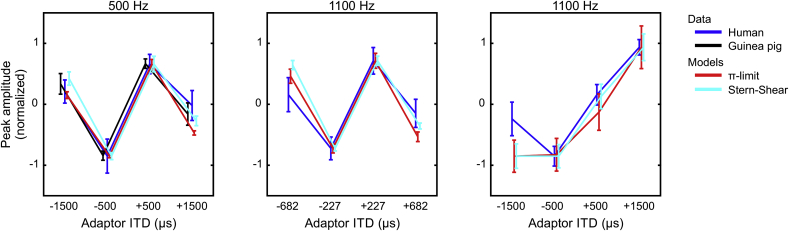
Predicted response amplitudes (average ± standard error of the mean over ten repetitions) from the computational model for the two distributions compared to the MEG data from humans and ECoG data from the guinea pig (plotted as in Fig. 3, Fig. 4). For illustration, peak amplitudes of the model predictions and ECoG data are scaled to have the same maxima and minima as the MEG data.